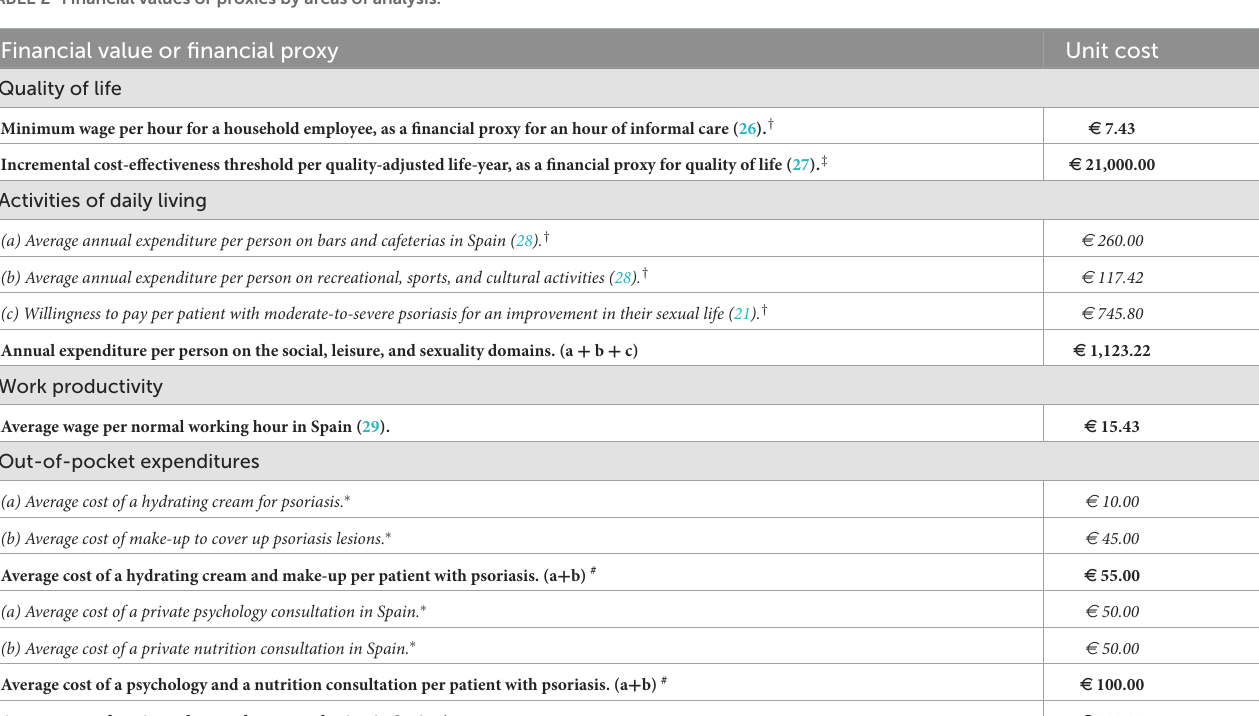
TABLE 2 Financial values or proxies by areas of analysis.